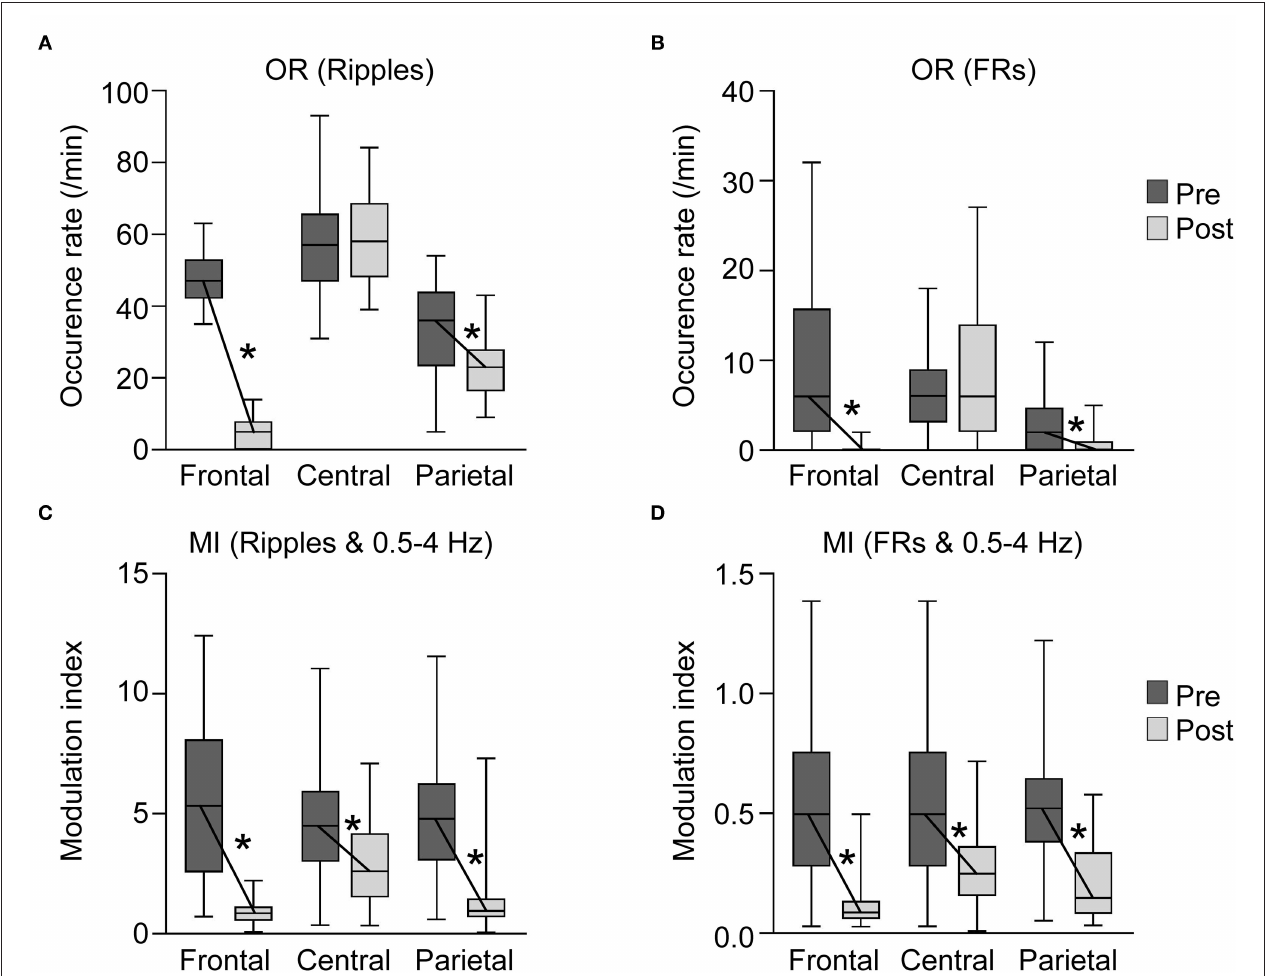
FIGURE 4 | Occurrence rates (ORs) of high-frequency oscillations (HFO) and modulation index (MI) in each area before and after subtotal hemispherotomy. (A,B) OR of HFOs in the frontal and parietal areas decreased significantly after subtotal hemispherotomy ( p < 0.01 for all), while they remained unchanged in the central area. (C,D) MI (HFO and slow wave bands) in all three areas decreased significantly after subtotal hemispherotomy ( p < 0.01 for all). Pre, before subtotal hemispherotomy; Post, after subtotal hemispherotomy; *indicates p <